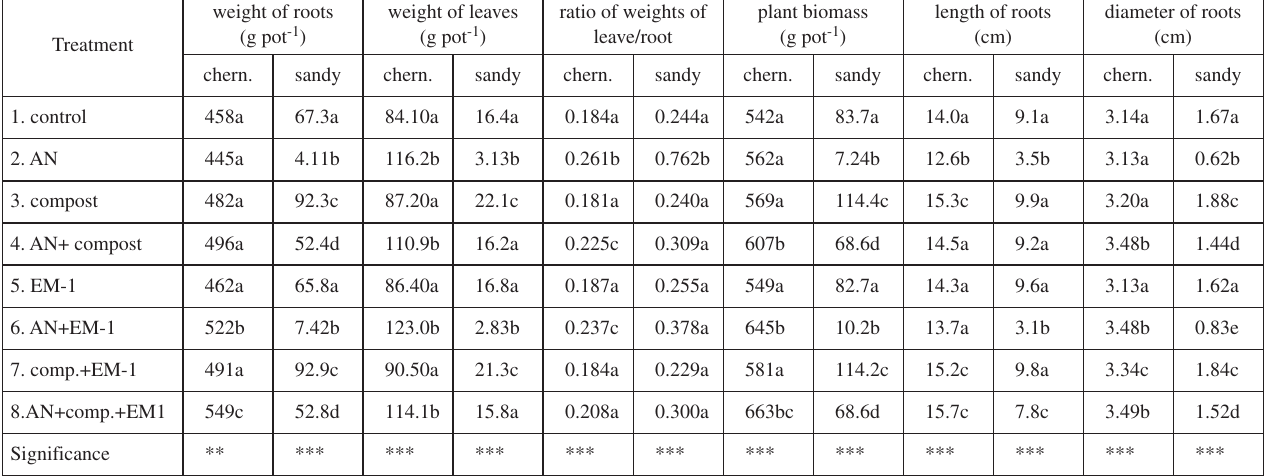
Table 4. Effects of treatments on plant biomass and yield